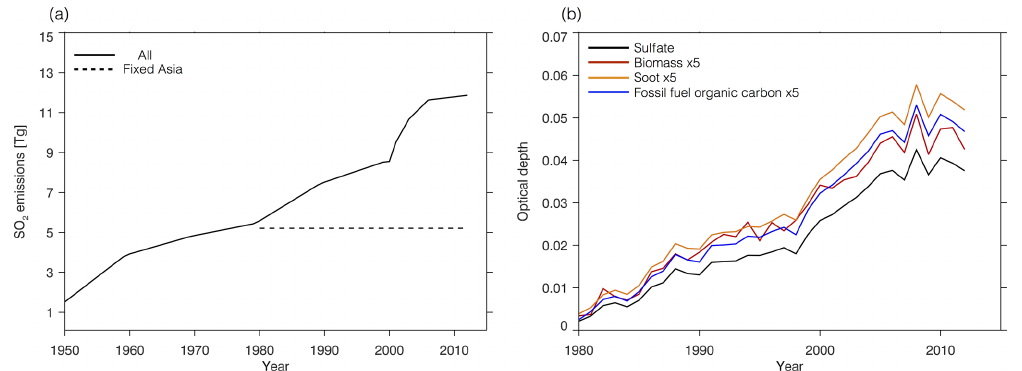
Figure 1. (a) Total emissions of sulfur dioxide over Asia from 1950 to 2012 in the historical experiment (solid line). The dashed line indicates 1971–1980 mean values, as used in the fixed Asia experiment. (b) Ensemble mean optical depth of anthropogenic aerosol species in response to Asian aerosol and precursor emissions (historical – fixed Asia), averaged over Asia.